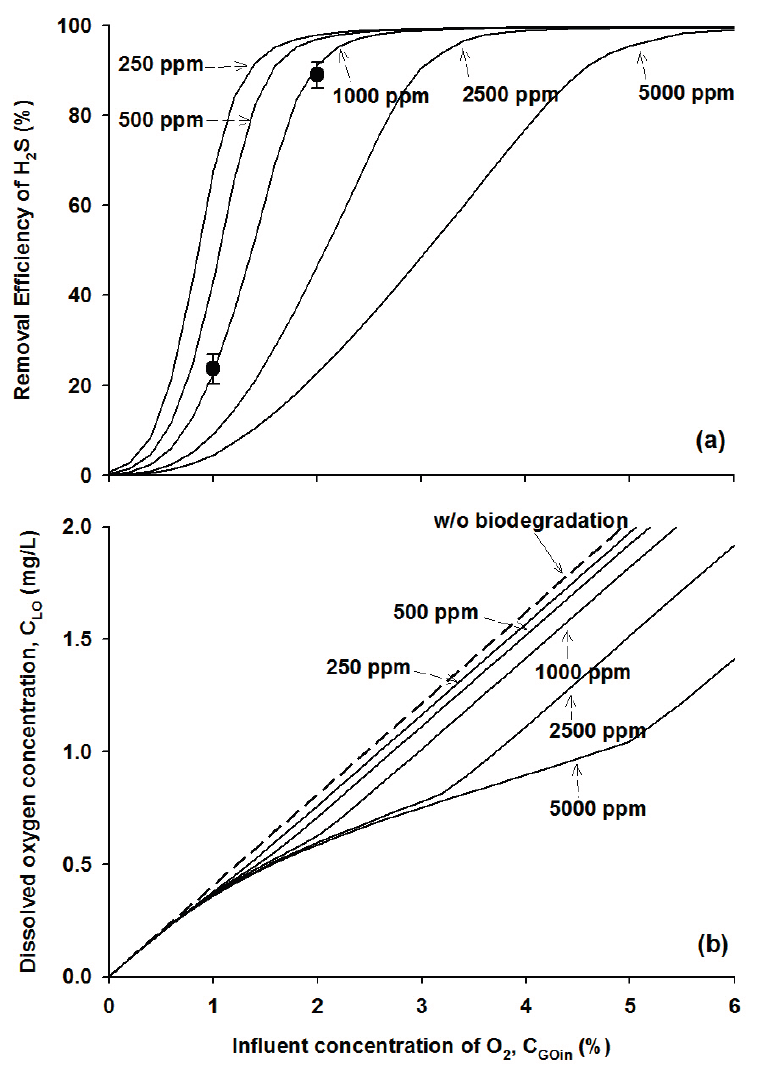
Figure 5. Experimental data (symbols) and model simulation results (lines) of ( a ) the H 2 S removal efficiency and ( b ) dissolved oxygen concentration at different influent oxygen contents and H 2 S